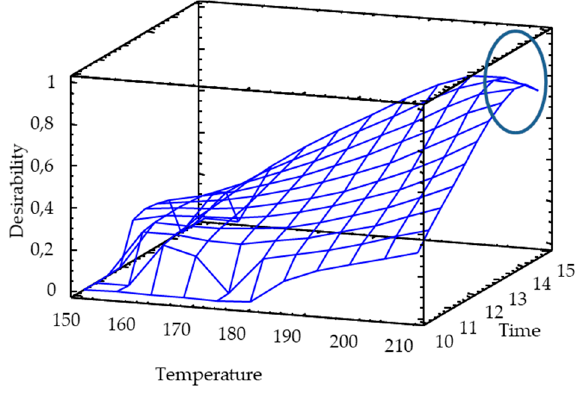
Figure 10. Simultaneous optimization by the desirability function approach.